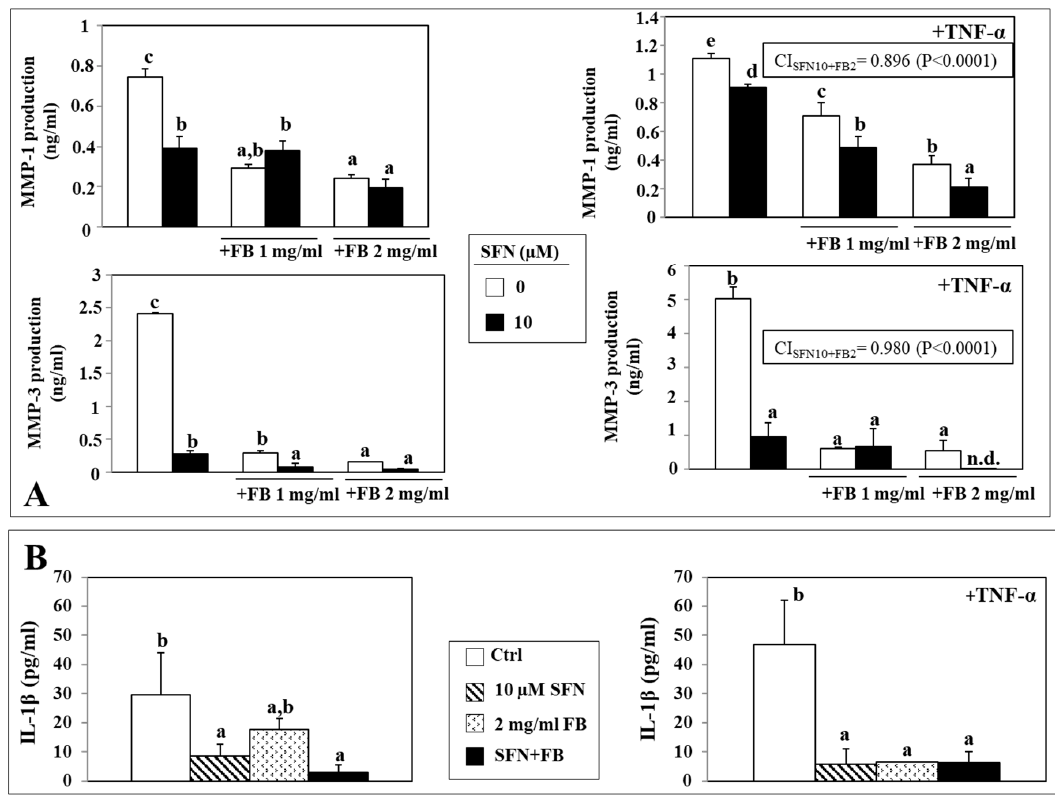
Figure 6. Effect of a 24 h-treatment with SFN (10 μ M) and FB (1 and 2 mg/mL), alone and in combination, on the secretion in the culture medium of metalloproteinases (MMP)-1 and -3 ( A ) and of IL-1 β ( B ) in NCTC2544 human keratinocytes in basal conditions and in the presence of TNF- α (20 ng/mL) as a pro-inflammatory stimulus. In each histogram, values not sharing the same superscript letter are significantly different ( p < 0.05, One-way ANOVA followed by Tukey’s test). Within panel A (MMP-1 and MMP-3 in the presence of TNF- α is shown the CI obtained following the treatment with SFN and FB at the highest concentrations (10 μ M SFN and 2 mg/mL FB). The interaction was considered significant when p < 0.05 (2 × 2 factorial ANOVA) (see Materials and Methods section for details).